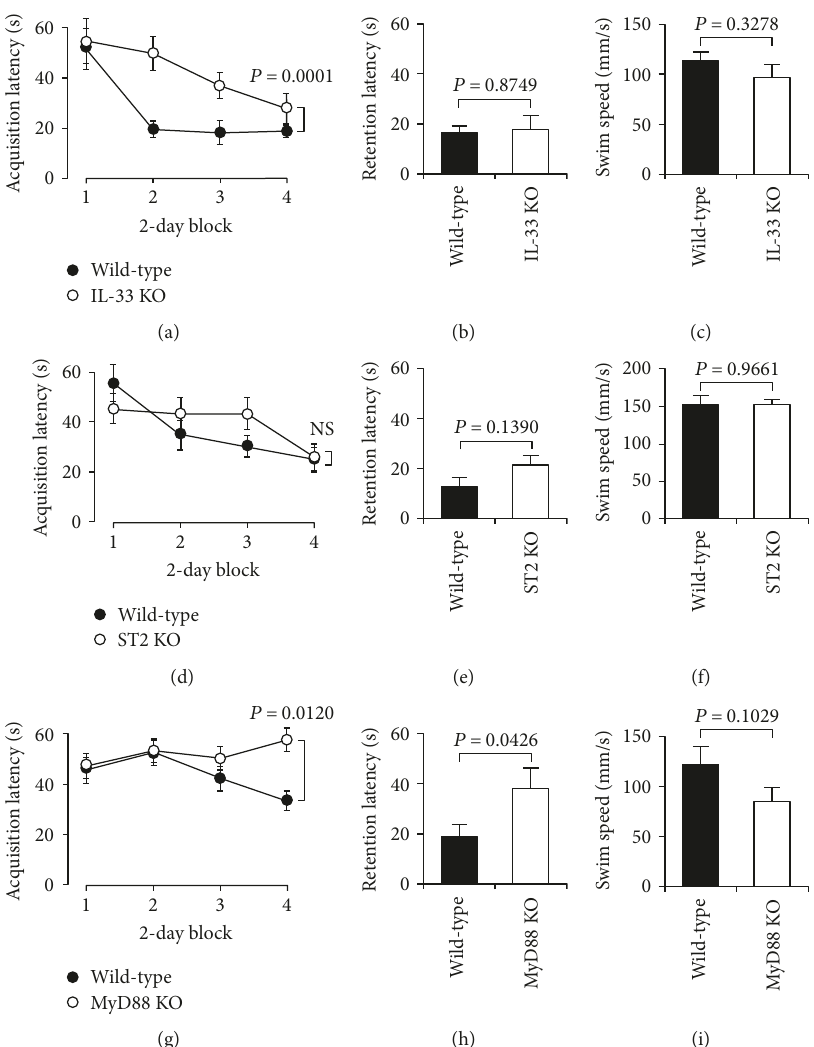
Figure 3: Water maze test. The water maze task was performed two trials per day for 8 consecutive days, and the acquisition latency was measured in wild-type mice (wild-type), IL-33-de fi cient mice (IL-33 KO), ST2-de fi cient mice (ST2 KO), and MyD88-de fi cient mice (MyD88 KO). Seven days later, the retention latency was measured. In addition, swim speed was calculated in each trial. (a, d, g) In the graphs, each point represents the mean ( ± SEM) acquisition latency from 2 consecutive days ( n =6-7 independent mice). P values, ANOVA followed by Fisher ’ s PLSD test. NS: not signi fi cant. (b, e, h) In the graphs, each column represents the mean ( ± SEM) retention latency ( n =6-7 independent mice). P values, unpaired t -test. (c, f, i) In the graphs, each column represents the mean ( ± SEM) swim speed ( n =6-7 independent mice). P values, unpaired t